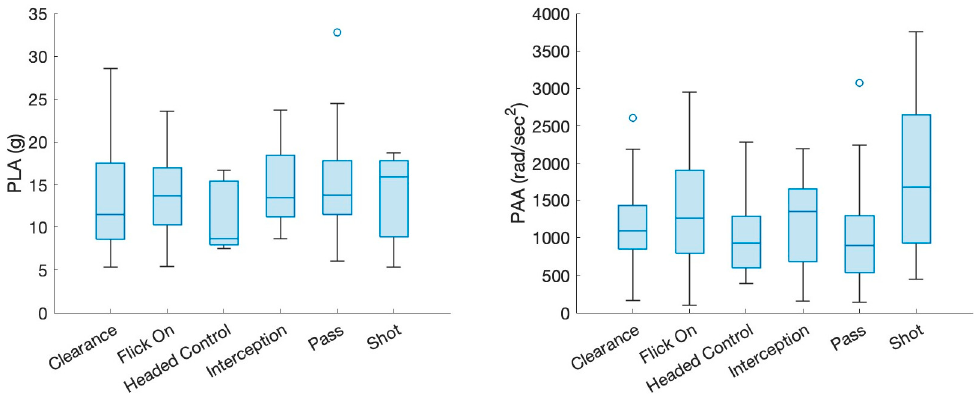
Figure 2. Heading kinematics based on the header types clearance (n = 24), flick on (n = 30), headed control (n = 5), interception (n = 19), pass (n = 50) and shot (n = 5). Tabulated results are available in Appendix A.